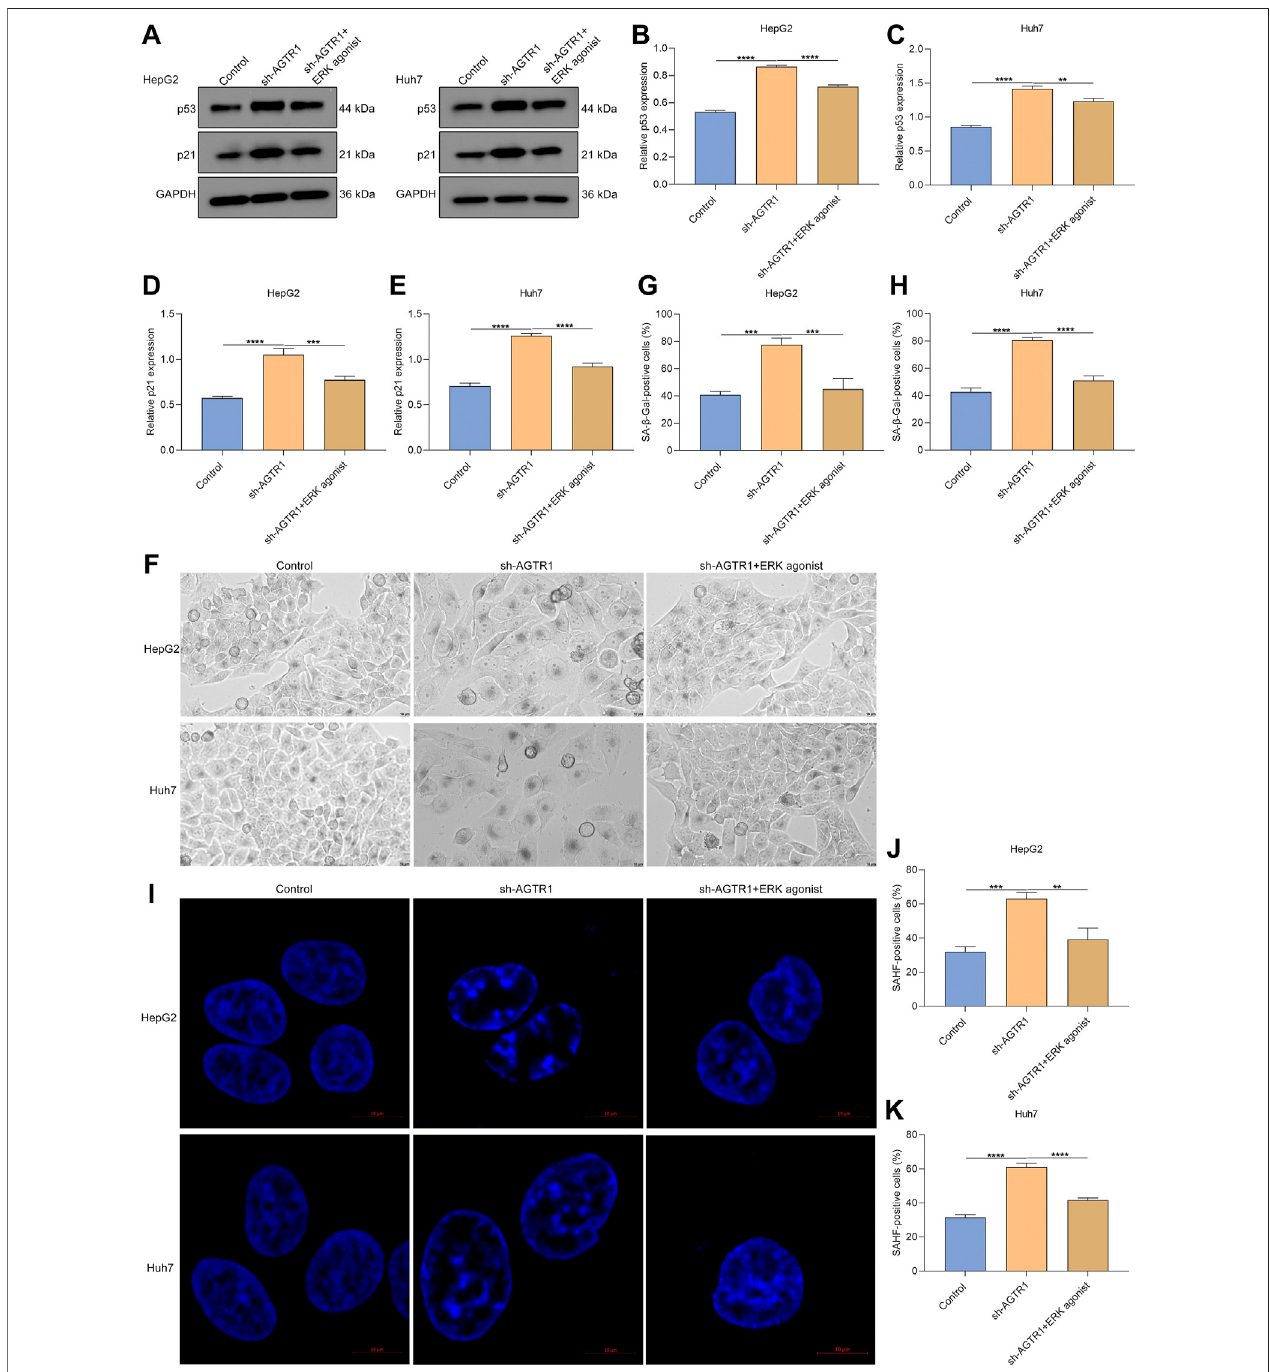
FIGURE7| AGTR1knockdown triggers cellular senescence ofHCC cells inanERK-dependent pathway. (A – E) p53 and p21protein expressions inHepG2 along with Huh7 cell lines with sh-AGTR1 lentivirus transduction or ERK agonist EGF. (F – H) SA- β -Gal activity of HCC cell lines with sh-AGTR1 lentivirus transduction or ERK agonist EGF. Scale bar, 10 μ m. (I – K) SAHF activity of HCC cell lines with sh-AGTR1 lentivirus transduction or ERK agonist EGF. Scale bar, 10 μ m.